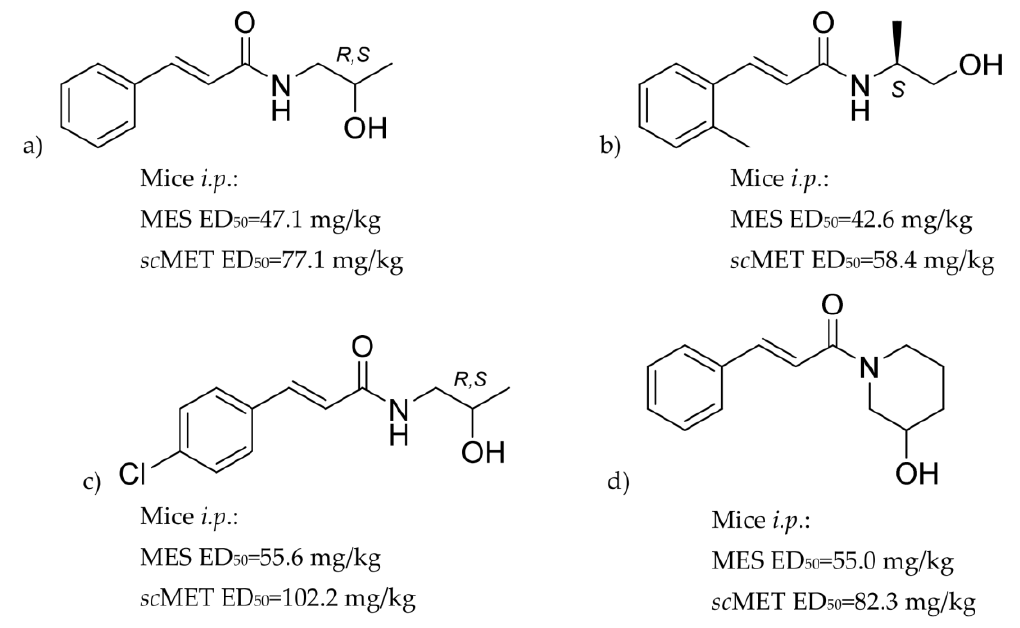
Figure 1. Structures of previously reported cinnamamide derivatives with anticonvulsant activity: ( a ) R,S -(2 E )- N -(2-hydroxypropyl)-3-phenylprop-2-enamide [19], ( b ) S -(2 E )- N -(1-hydroxypropan-2-yl)-3-(2-methylphenyl)prop-2-enamide [21,22], ( c ) R,S -(2 E )-3-(4-chlorophenyl)- N -(2-hydroxypropyl)prop-2-enamide [21,22], ( d ) R,S -(2 E )-1-(3-hydroxypiperidin-1-yl)-3-phenylprop-2-en-1-one [17].